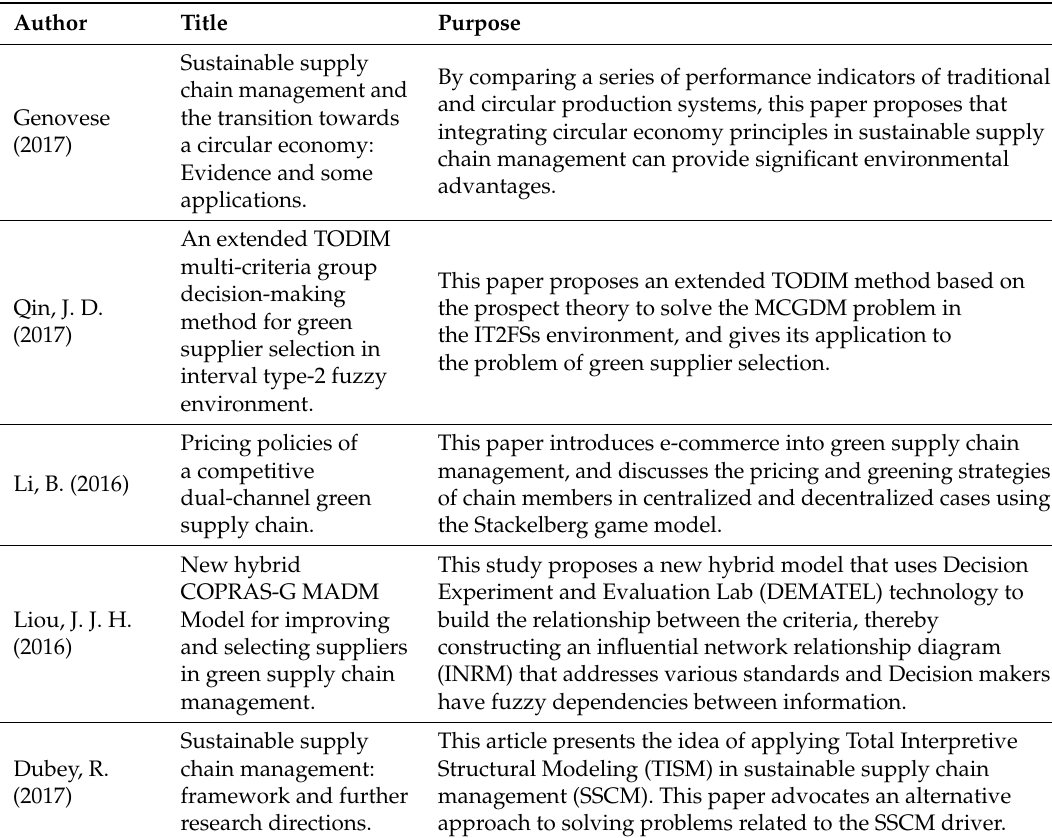
Table 1. Top 10 cited works in green supply chain